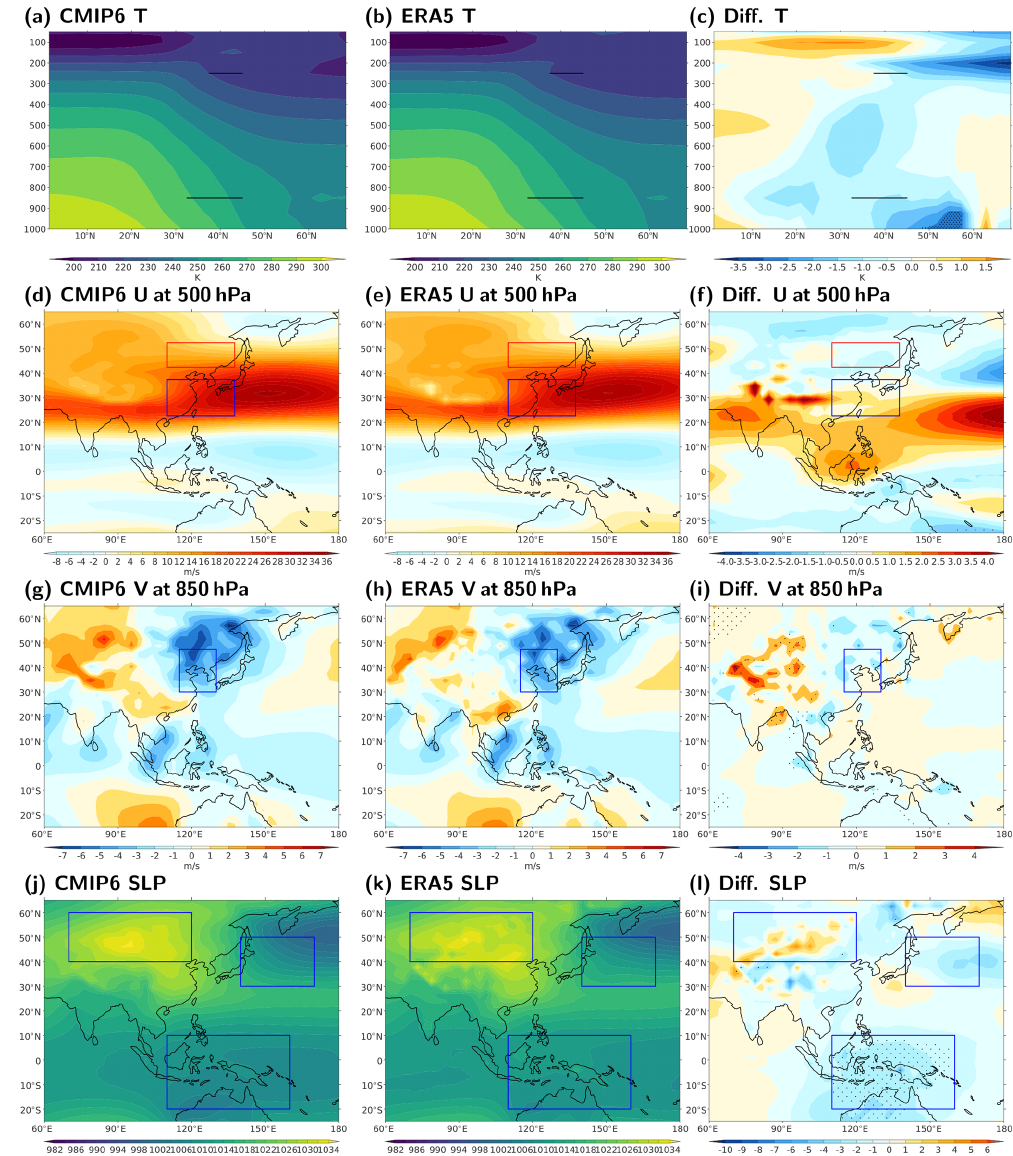
Figure 2. Biases in present-day East Asian winter monsoon (DJF 1979–2014). (a–c) Zonal mean temperature averaged between 112.5– 137.5 ◦ E for CMIP6, ERA5, and their difference. (d–f) 500hPa zonal wind. (g–i) 850hPa meridional wind. (j–l) Sea level pressure. Dif- ference that is above 90% confidence level is stippled. Boxes indicate areas from which averaged values are used to compute HWI and